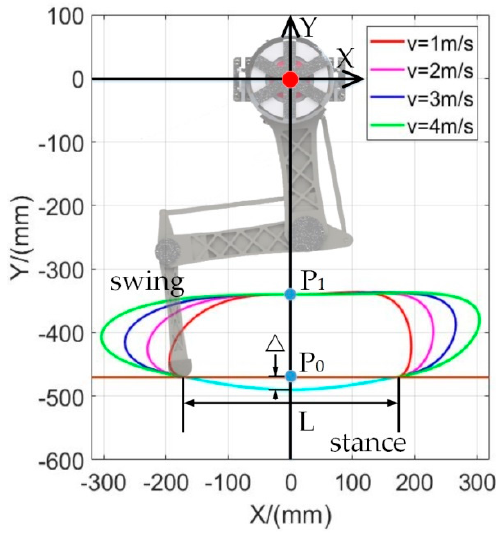
Figure 11. The spline curve trajectory.